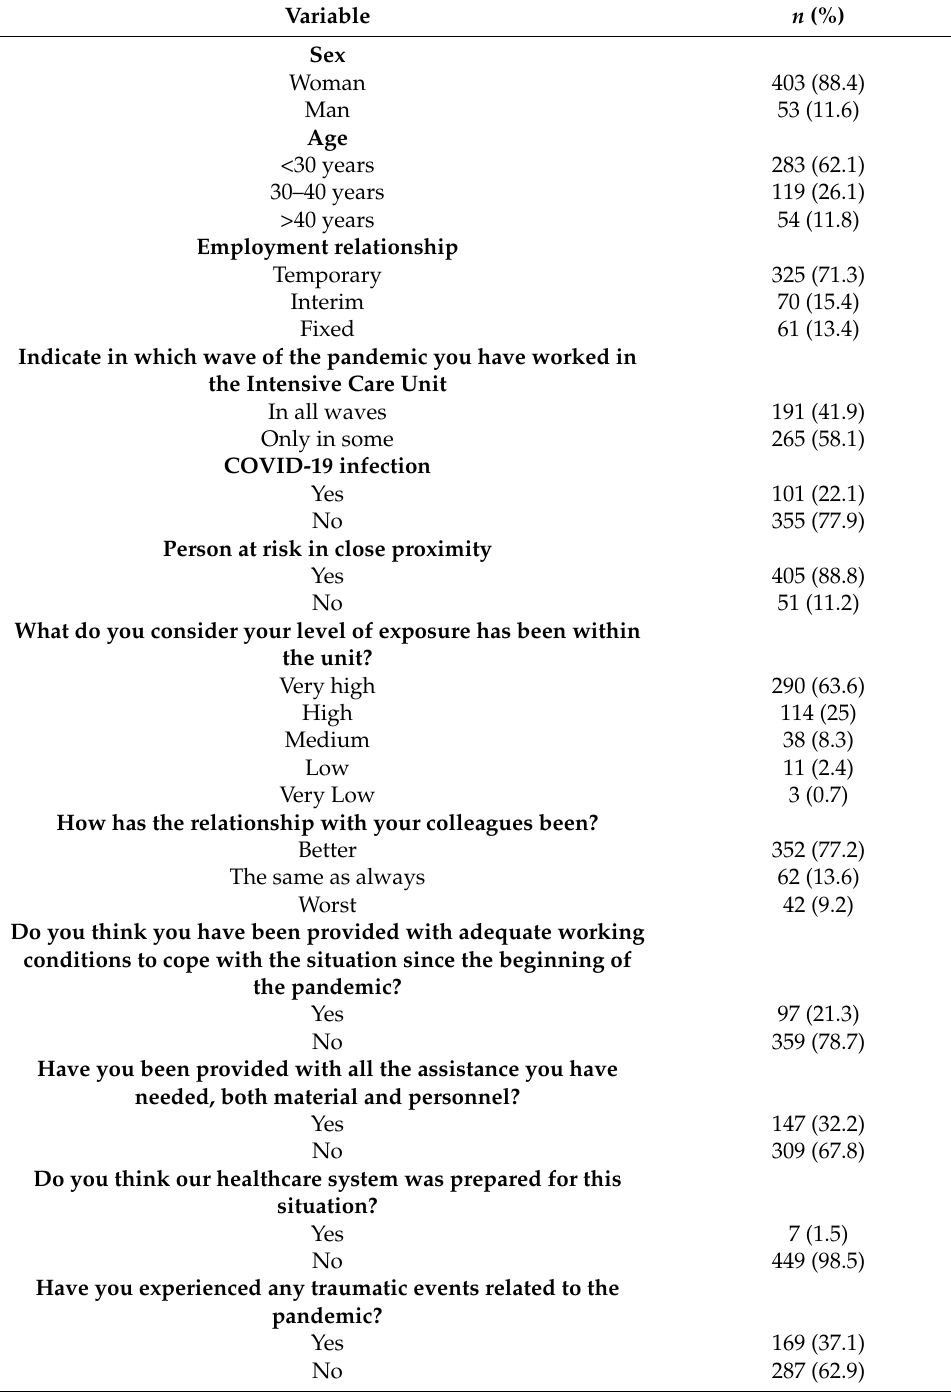
Table 1. General characteristics of surveyed nurses ( n =